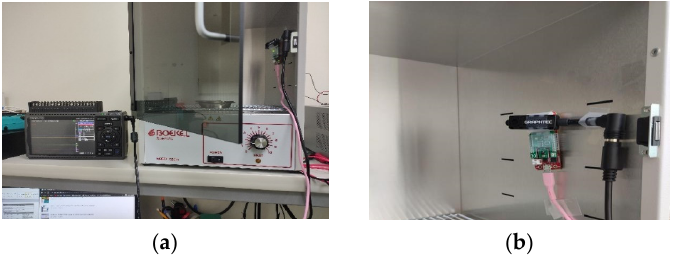
Figure 10. Calibration process of wireless climate sensor node: ( a ) measurement setup, ( b ) sensor